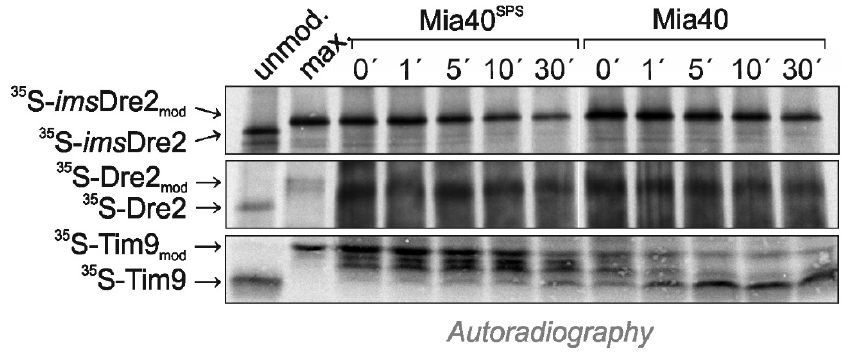
FIGURE 7: Tim9, but not Dre2, is oxidized by recombinant Mia40 in vitro . Radiolabeled ims Dre2, Dre2 and Tim9 were reduced and either directly loaded to the gel (unmodified, unmod.), or incubated with 35 µM Mia40 SPS or Mia40 for the times indicated, denatured with SDS and treated with 15 mM mPEG-12. For control, a sample of reduced protein was directly treated with mPEG-12 so that all thiols are alkylat- ed (maximum shift,